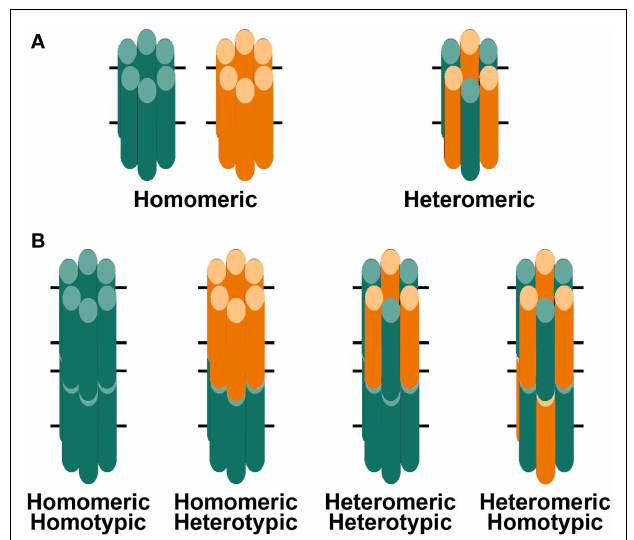
FIGURE 2 | Diagrams of hemichannels (A) and intercellular channels (B) formed from a single connexin or two different connexins. (A) Six identical connexin subunits (green or orange) can oligomerize to form a homomeric hemichannel.Two co-expressed connexins may oligomerize with each other to form a heteromeric hemichannel. (B) Two hemichannels dock with each other to form a complete gap junction channel.Two hemichannels of similar composition form homotypic channels whereas two hemichannels of different composition form heterotypic